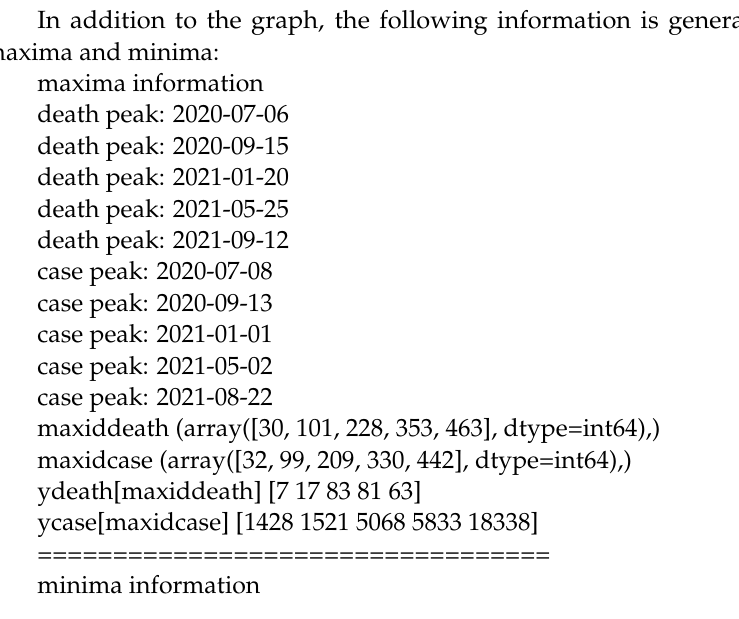
Figure 1. Case fatality rate and lag time in Japan as of 18 October 2021.